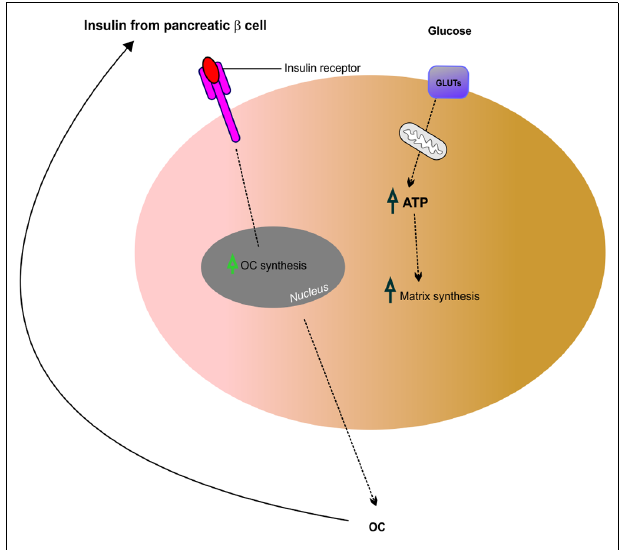
FIGURE 4 | Putative mechanism of insulin signaling and osteocalcin regulation in osteoblasts. Insulin released from pancreatic β cells binds the insulin receptor (InsR) on osteoblasts, which increases osteocalcin (OC) synthesis.This feeds back in a forward loop to β cells thus stimulating insulin secretion and also regulating glucose homeostasis potentially via GLUTs expressed in osteoblasts. Adapted from Fulzele and Clemens